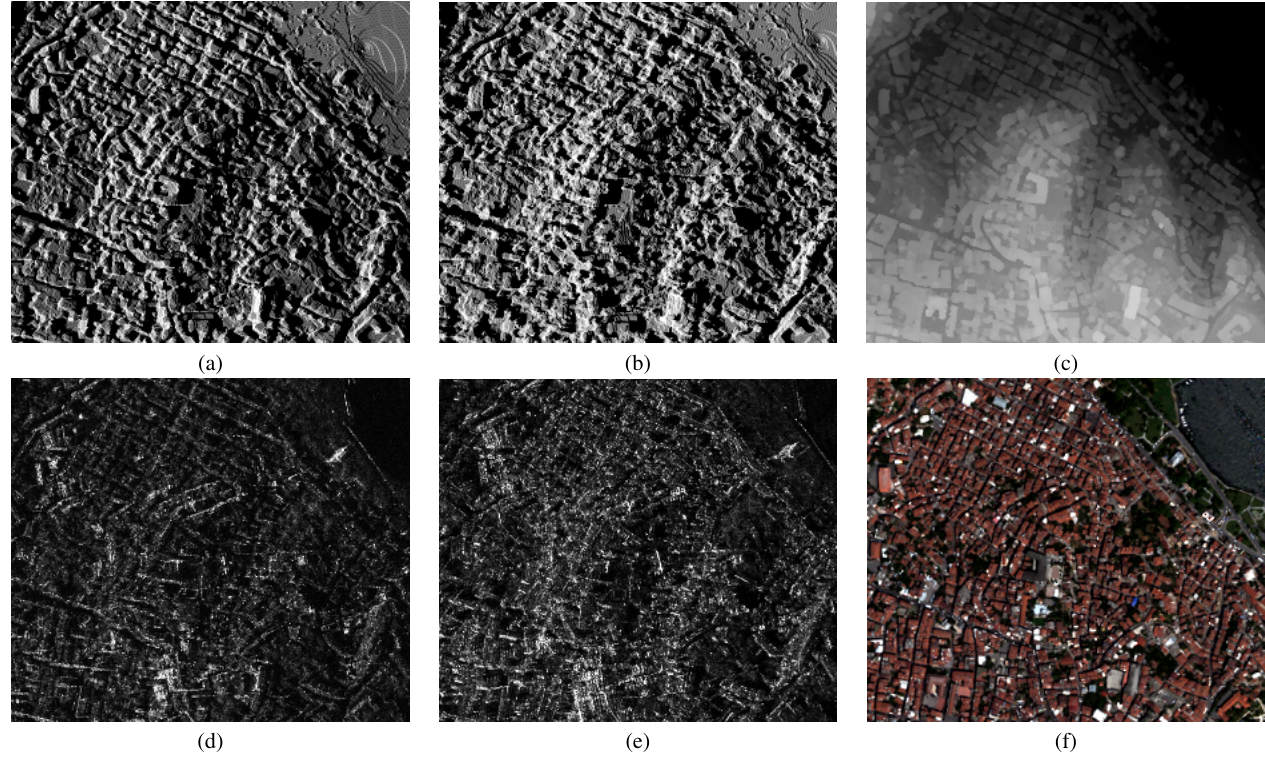
Figure 5. North western parts of district Fatih in Istanbul; (a) and (b): simulated SAR images; (c): unprocessed DSM; (d) and (e): corresponding TerraSAR-X images acquired on 5th of May 2008 and 11th of May 2008; (f): optical image, acquired with WorldView-2 on 15th of July